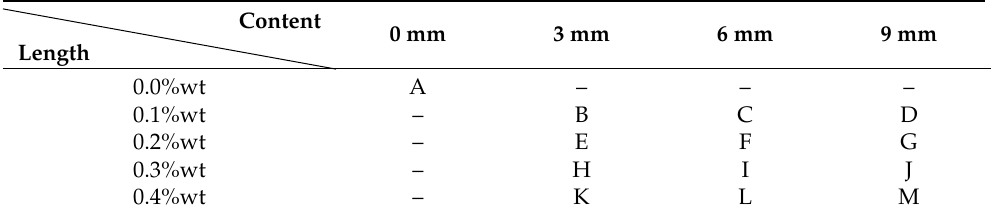
Table 2. Length and content of carbon fiber of different